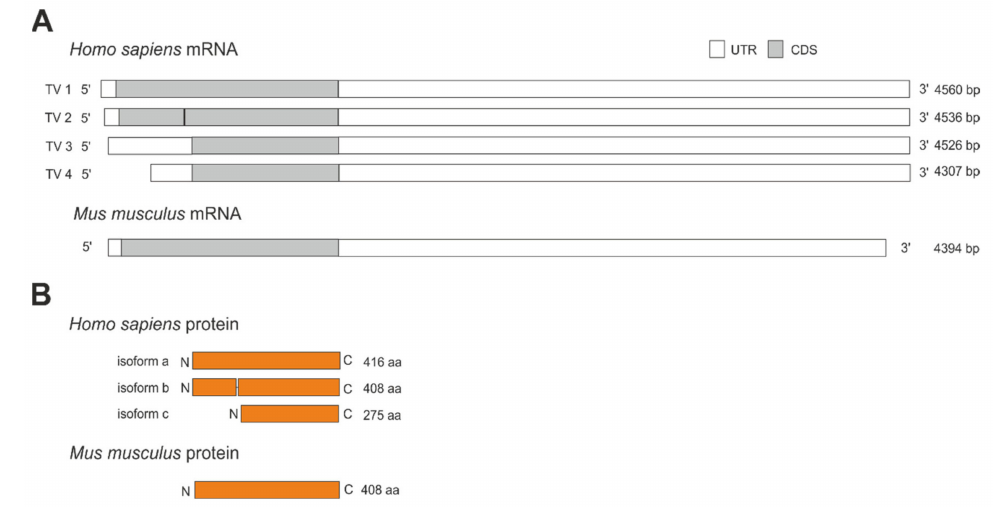
Figure 2. Transcript variants and protein isoforms of human and murine Nceh1 . ( A ) The human NCEH1 gene transcribes into 4 different transcript variants (TV) generated by alternative splicing or translation start codon usage ranging from 4307 to 4560 bp. Transcript variants vary in the 5 (cid:48) and 3 (cid:48) untranslated region (UTR) and coding sequence (CDS). The murine Nceh1 gene transcribes into a single 4394 bp long mRNA. ( B ) Human protein isoform A consists of 416 amino acids (aa). Isoform B is lacking 8 aa (position 123–130), leading to a shorter 408 aa protein. Isoform C is lacking 141 aa at the N-terminus, leading to the shortest protein consisting of 275 aa. The murine Nceh1 gene encodes for a single protein isoform consisting of 408 aa.